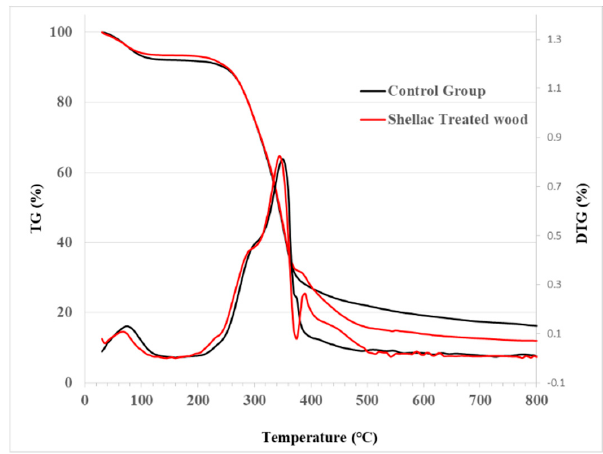
Figure 4. Thermogravimetric (TG) and derivative thermogravimetric (DTG) curves of untreated wood samples and samples treated with